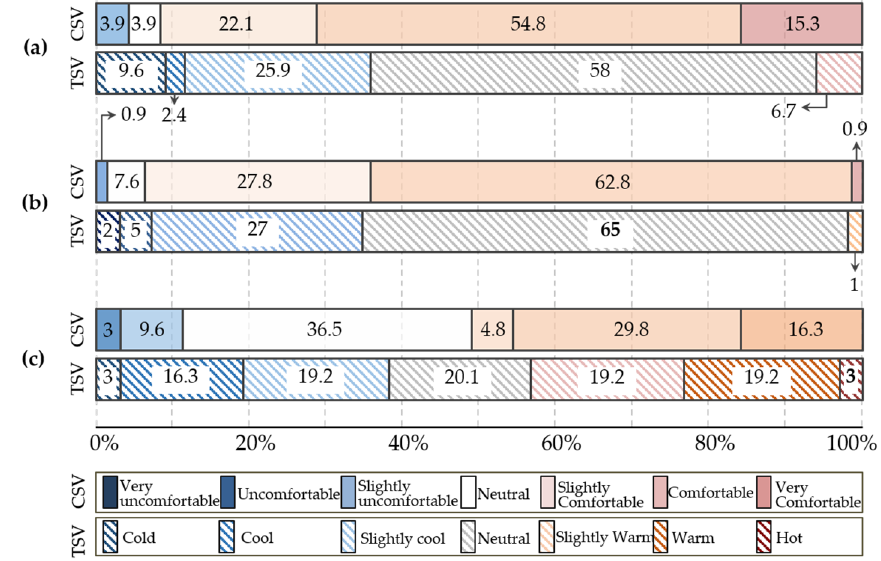
Figure 5. Thermal comfort of the occupants: ( a ) results graph of thermal comfort to control group; ( b ) results graph of thermal comfort to experimental group A; ( c ) results graph of thermal comfort to experimental group B.